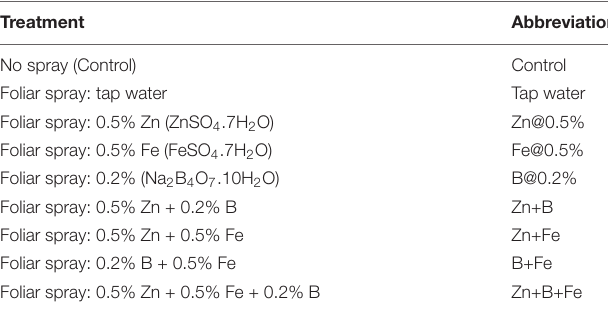
TABLE 1 | Treatment description and